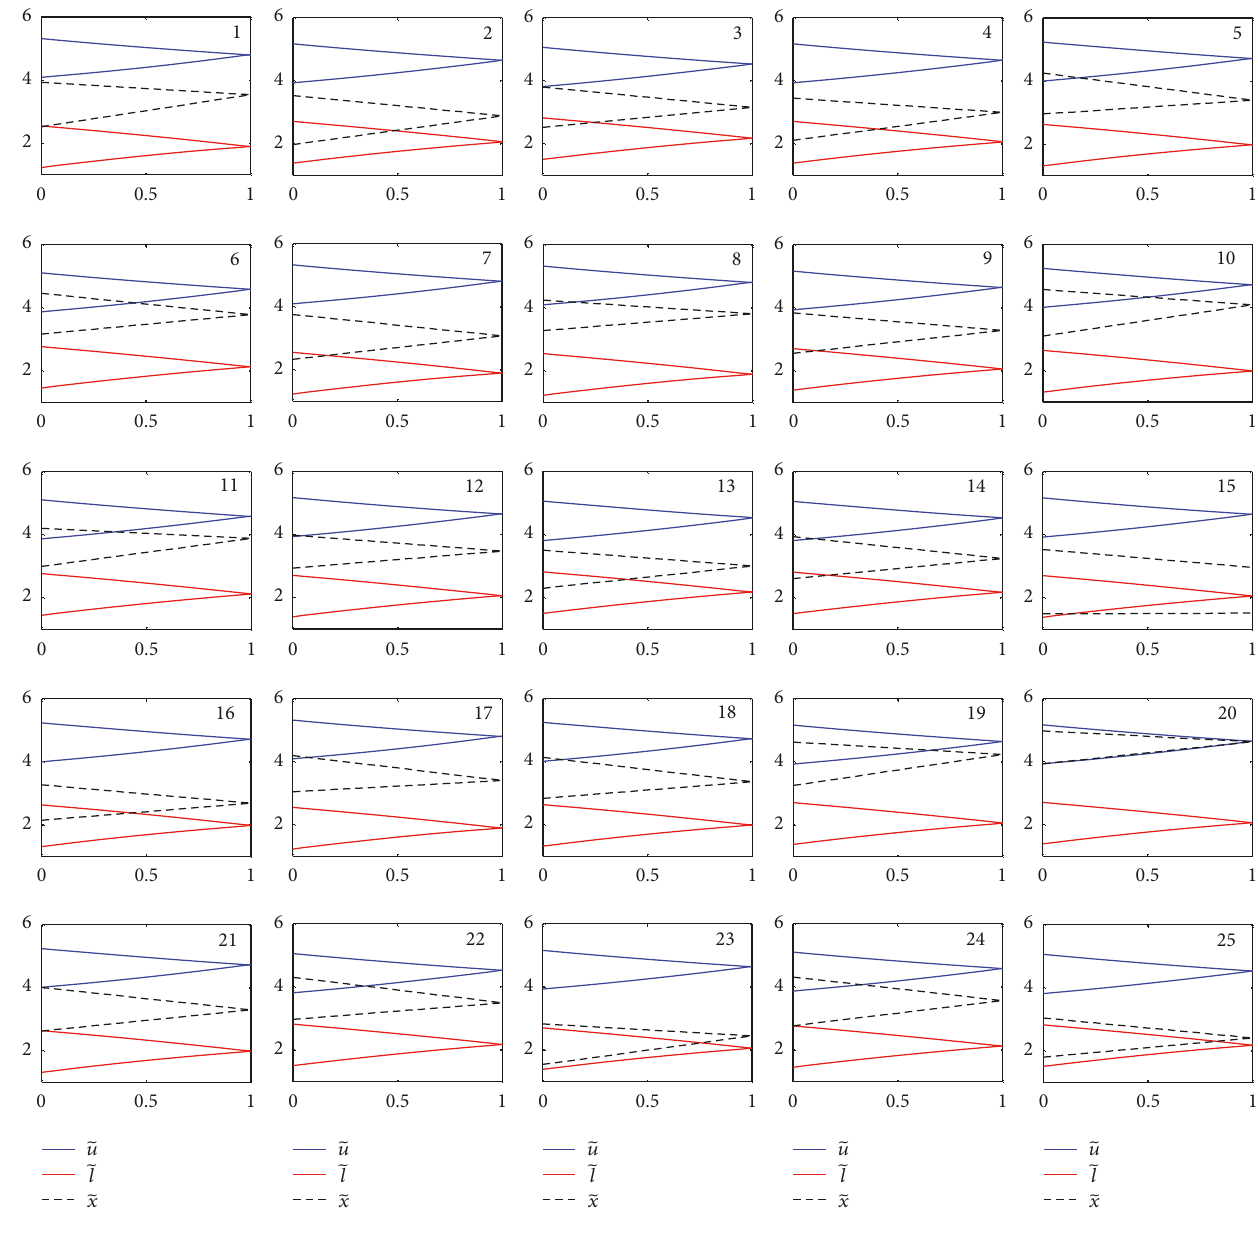
Figure 6: Fuzzy 𝑥 chart for roughness height of optical